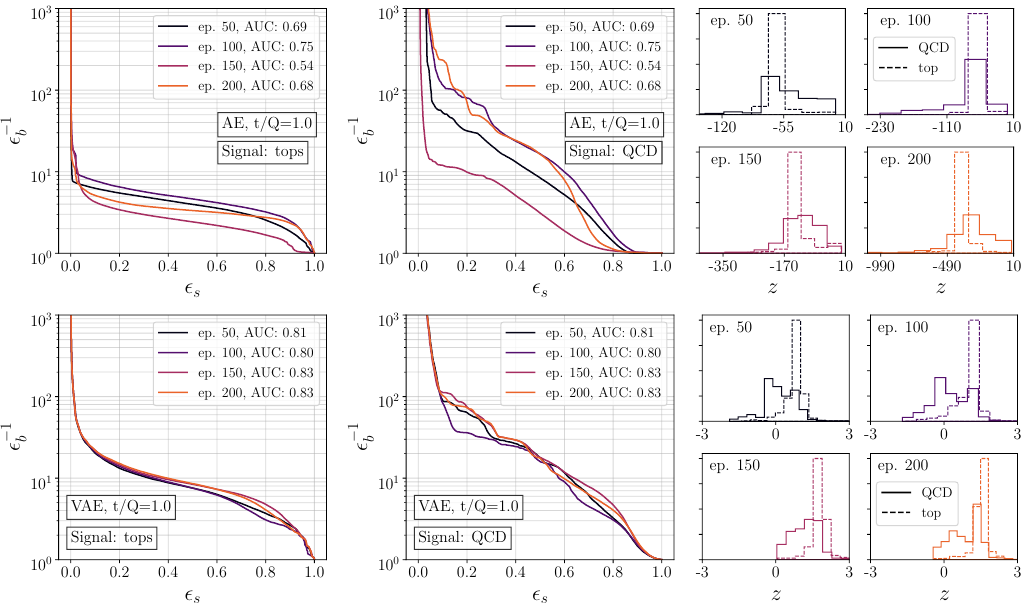
Figure 3: Results for the 1D AE (top) and VAE (bottom). In the large panels we show the ROC curves for tagging top and QCD as signal. In the small panels we show the distributions of the top and QCD jets in the bottleneck or latent space developed over the